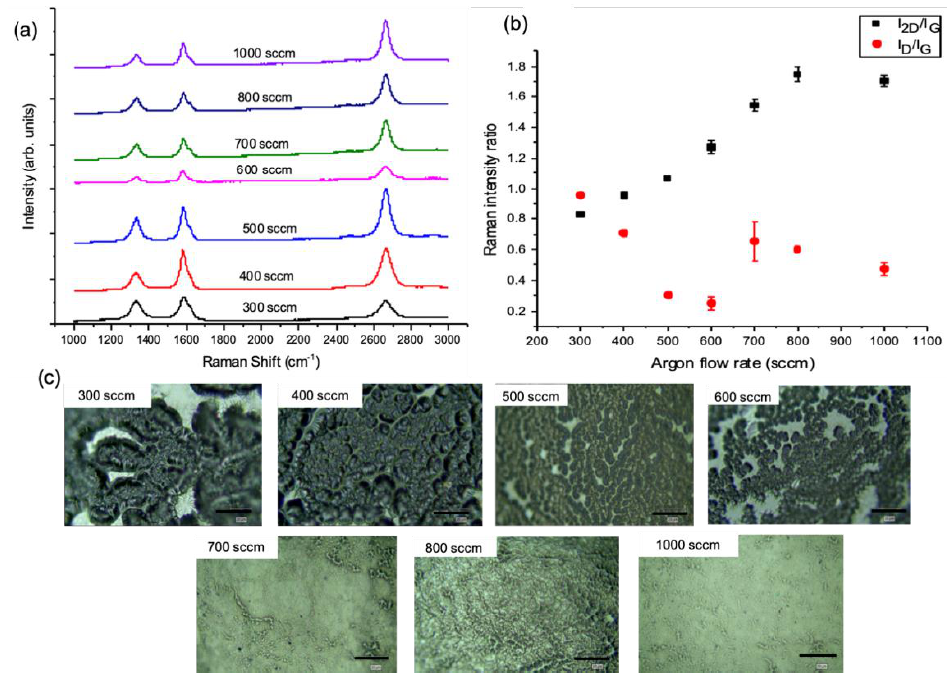
Figure 3. ( a ) Raman spectra of the graphene grown on liquid In showing the effect of changing the Ar flow rate. ( b ) Average Raman intensity ratio for the I 2D /I G and I D /I G values vs. the Ar flow rate based on map data (error bars are smaller than some of the data points). ( c ) Optical images of the grown graphene films (scale bar: 20 µm), some blurriness is due to the surface curvature of the solidified In (APCVD, T = 1120 ◦ C, 20 H 2 /(300–1000) Ar/5 CH 4 sccm, t = 5 min).